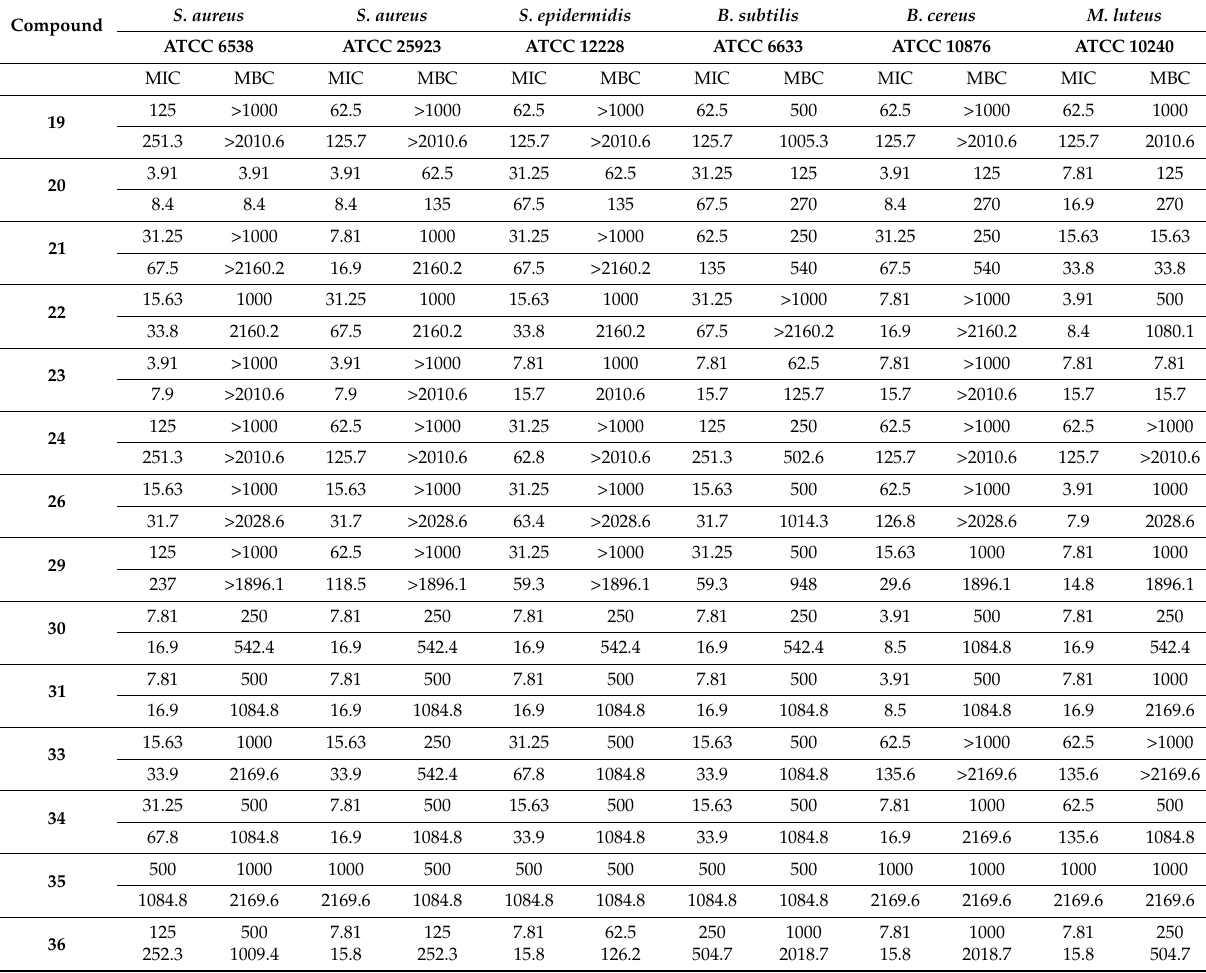
Table 1. The activity of chlorophenylthiosemicarbazones ( 17 – 40 ) against Gram-positive bacteria determined on the basis of MIC (minimal inhibitory concentration, in mg/L and µ M) and MBC (minimal bactericidal concentration, in mg/L and µ